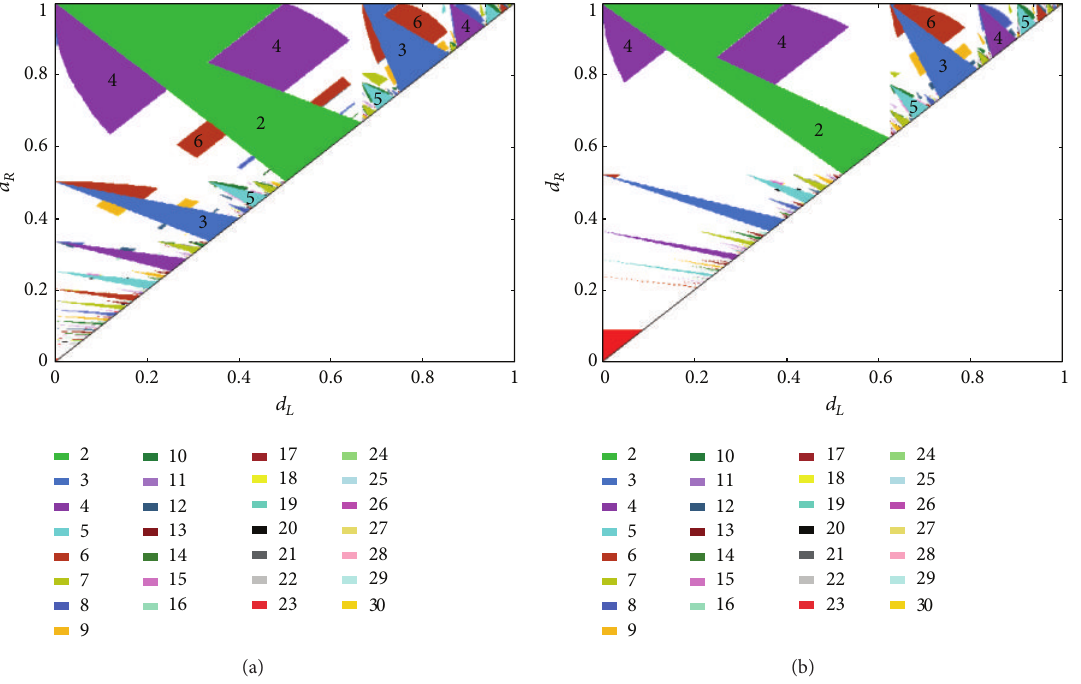
Figure 4: 2D bifurcation diagram of 𝑓 in the (𝑑 𝐿 , 𝑑 𝑅 ) -parameter plane for 𝑎 𝐿 = 0.5 , 𝑎 𝑅 = 1.01 in (a), and 𝑎 𝐿 = 0.6 , 𝑎 𝑅 = 1.1 in (b). The small red region in (b) (see left bottom), defined by 𝑑 𝐿 < 𝑑 𝑅 < 1 − 1/𝑎 𝑅 , is related to divergent orbits and not involved in the economic model.